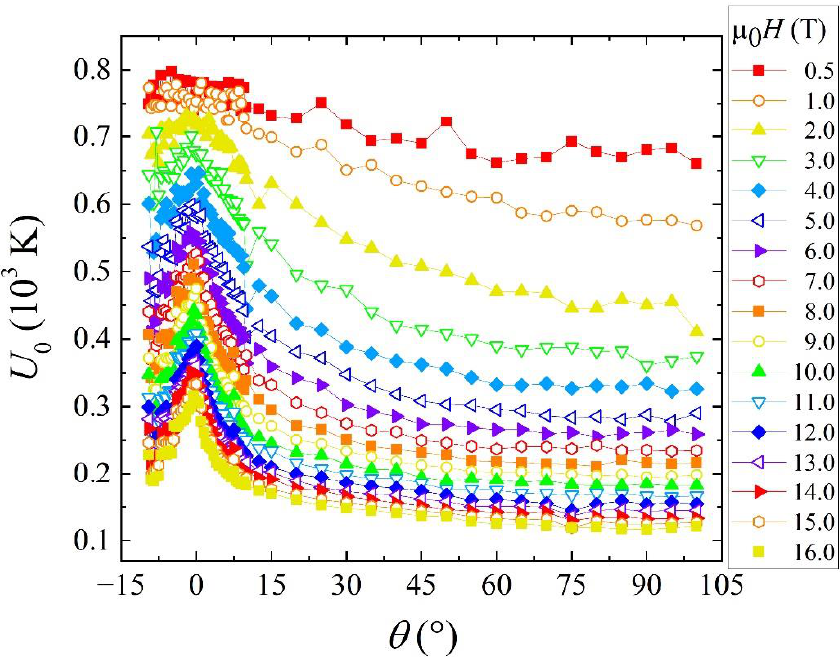
Figure 2. Flux pinning energy as a function of the angle θ up to µ 0 H = 16 T.